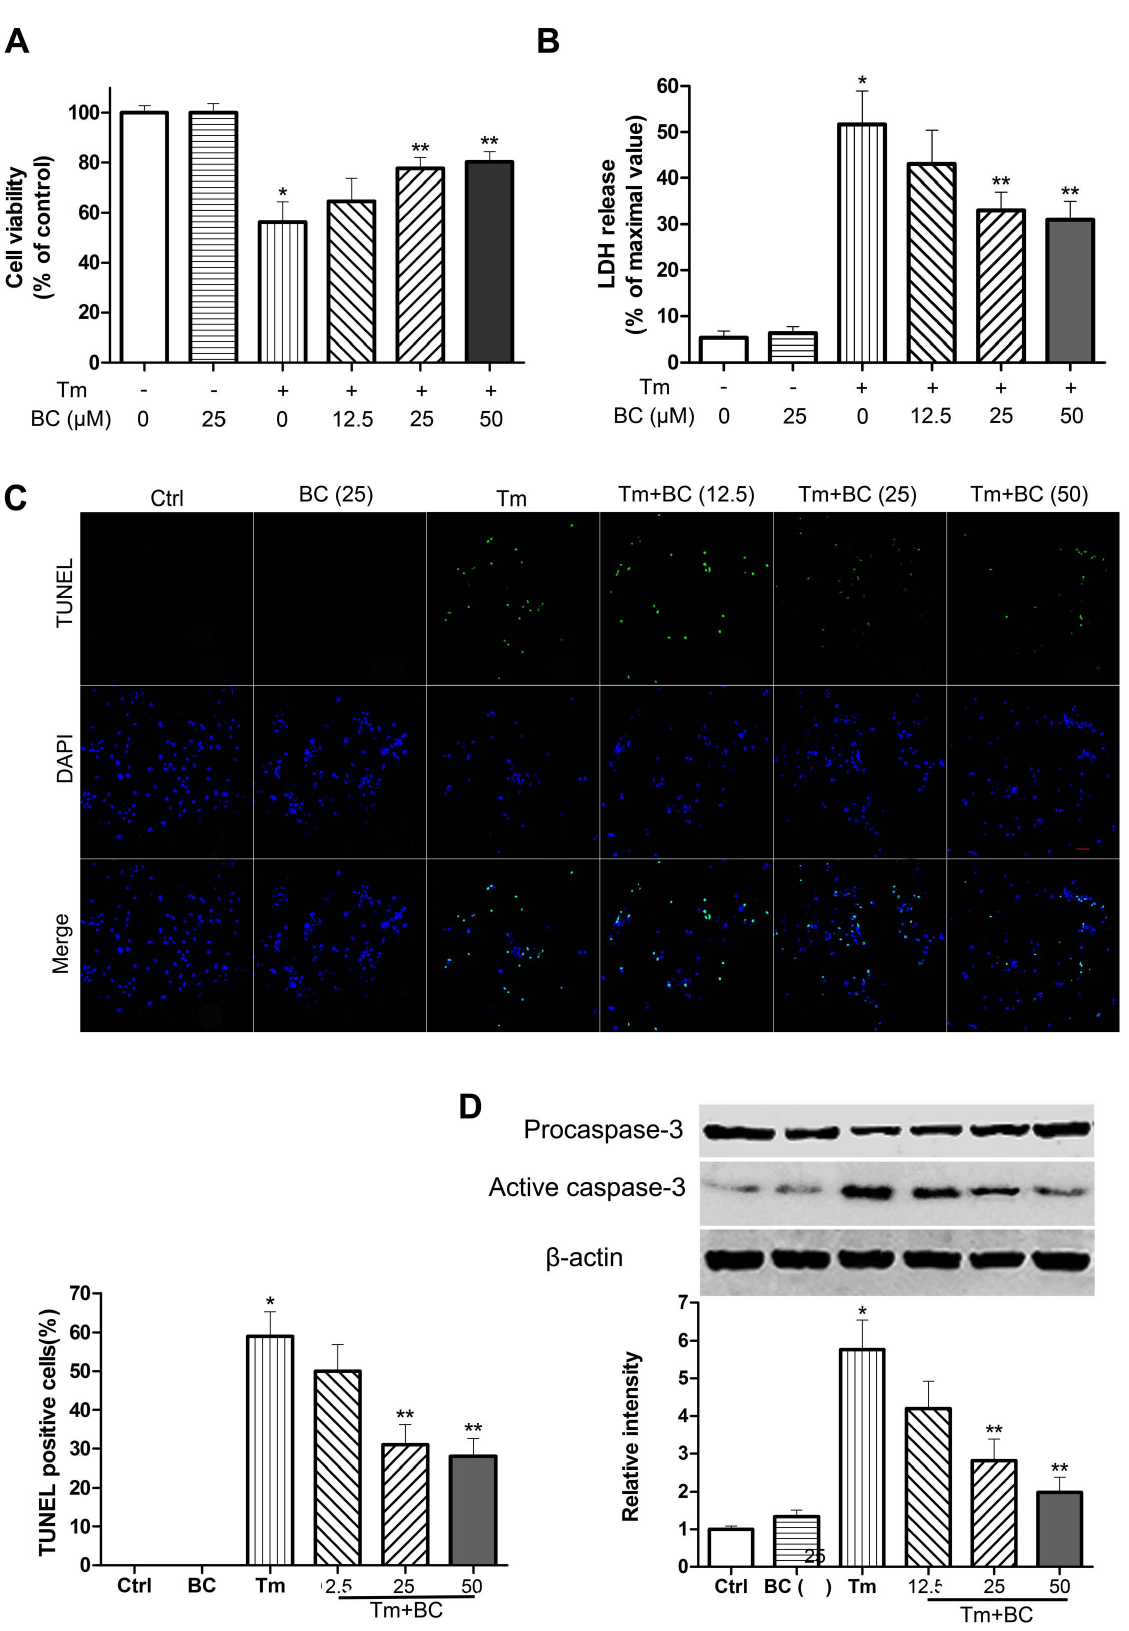
Figure 3. Protective effect of baicalin on tunicamycin-induced cardiomyocyte death. Cardiomyocytes were treated with Tm (100 ng/ml) in the presence or absence of baicalin (BC) at indicated concentrations (12.5, 25, 50 m M). (A) Protective effect of baicalin (BC, 72 h) on Tm-induced